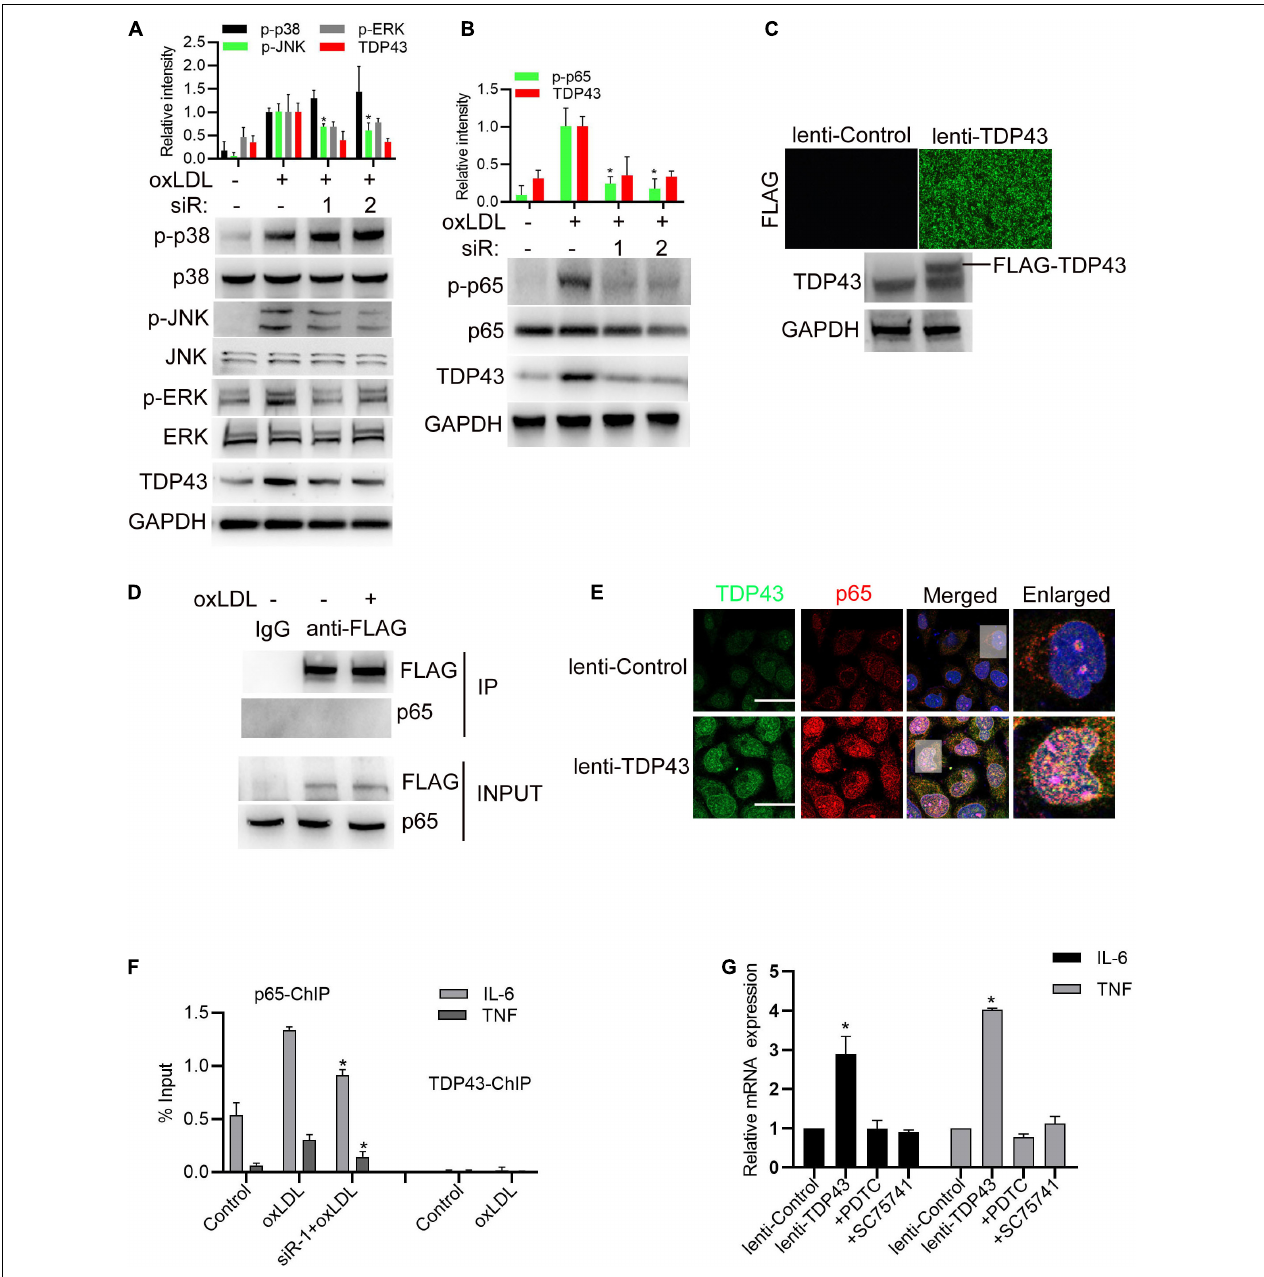
FIGURE 3 | Transactive response DNA-binding protein ∼ 43 kDa (TDP43) promotes activation of NF- κ B signaling to increase inflammatory factor expression in macrophages. (A,B) Western blot analysis of MAPKs and NF- κ B signaling in macrophages transfected with TDP43 specific siRNA ( − 1, − 2) or si-nc for 24 h and later incubated with 40 µ g/mL oxLDL for 24 h. Data are represented as means ± SD ( n = 3; * P < 0.05 vs. oxLDL stimulated group). (C) Immunofluorescence analysis of FLAG-tagged TDP43 expression in macrophages infected with lenti-control or lenti-TDP43 for 48 h (upper panel). Western blot analysis of TDP43 in macrophages infected with lenti-control or lenti-TDP43 for 48 h with GAPDH as a loading control (down panel). (D) Co-IP detection of the interaction between FLAG-tagged TDP43 and p65 in macrophages infected with lenti-control or lenti-TDP43 for 24 h and later incubated with or without 40 µ g/mL oxLDL for 24 h by using FLAG antibody. (E) Immunofluorescence analysis of TDP43 and phosphorylated p65 (p-p65) in macrophages infected with lenti-control or lenti-TDP43 for 48 h. Scale bar = 40 µ m. (F) ChIP analysis of the binding of p65 or TDP43 to IL-6 or TNF promoter in macrophages transfected with TDP43 specific siRNA (-1) or si-nc for 24 h and later incubated with 40 µ g/mL oxLDL for 24 h. Data are represented as means ± SD ( n = 3; * P < 0.05 vs. oxLDL stimulated group). (G) q-PCR detection of IL-6 and TNF mRNA expressions in macrophages incubated with PDTC or SC75741 (two NF-KB signaling inhibitors with different targets) for 1 h and later infected with lenti-control or lenti-TDP43 for 48 h Data are represented as means ± SD ( n = 3; * P < 0.05 vs. lenti-control group).